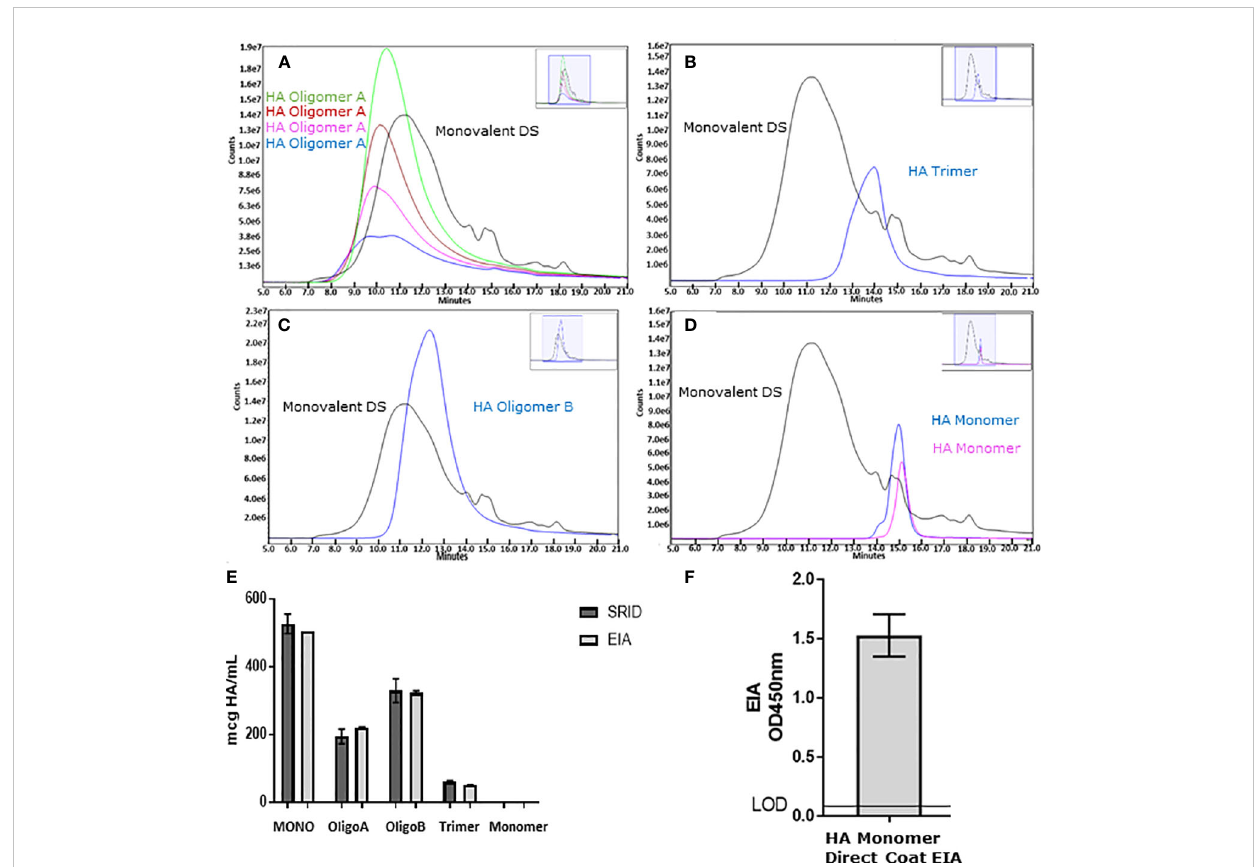
FIGURE 1 To understand the ELISA ’ s reactivity to different species of HA, Flucelvax ® Monobulk (H1N1; A/Delaware/55/2019) was separated via SE-UHPLC into four enriched species of HA including: HA oligomer A species >670kDa pool of sub-fractions green, red, pink and blue traces (A) , HA oligomer B species approximately 300kDa blue trace (B) , HA trimer between 200-300kDa blue trace (C) and HA monomer between 60-100kDa pool of sub- fractions blue and pink traces (D) . Fractions and Monobulk control antigen, normalised to total protein concentration, was assessed by ELISA (light grey) and SRID (dark grey) to determine HA potency (E) . Error bars represent standard deviation between potency replicates. Monomer HA fraction was further assessed in direct coat ELISA to verify monomeric HA sub-units were native and correctly folded (F) . Error bars represent standard deviation between OD450nm replicate